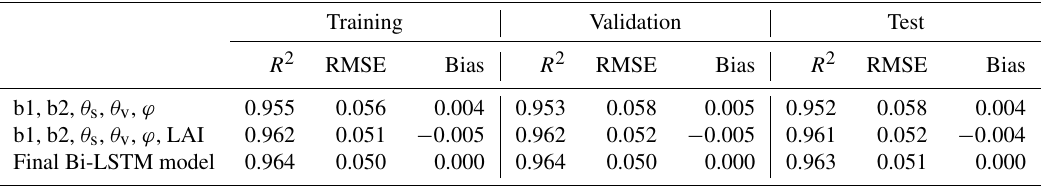
Table 1. Accuracies of Bi-LSTM models with different combinations of features.